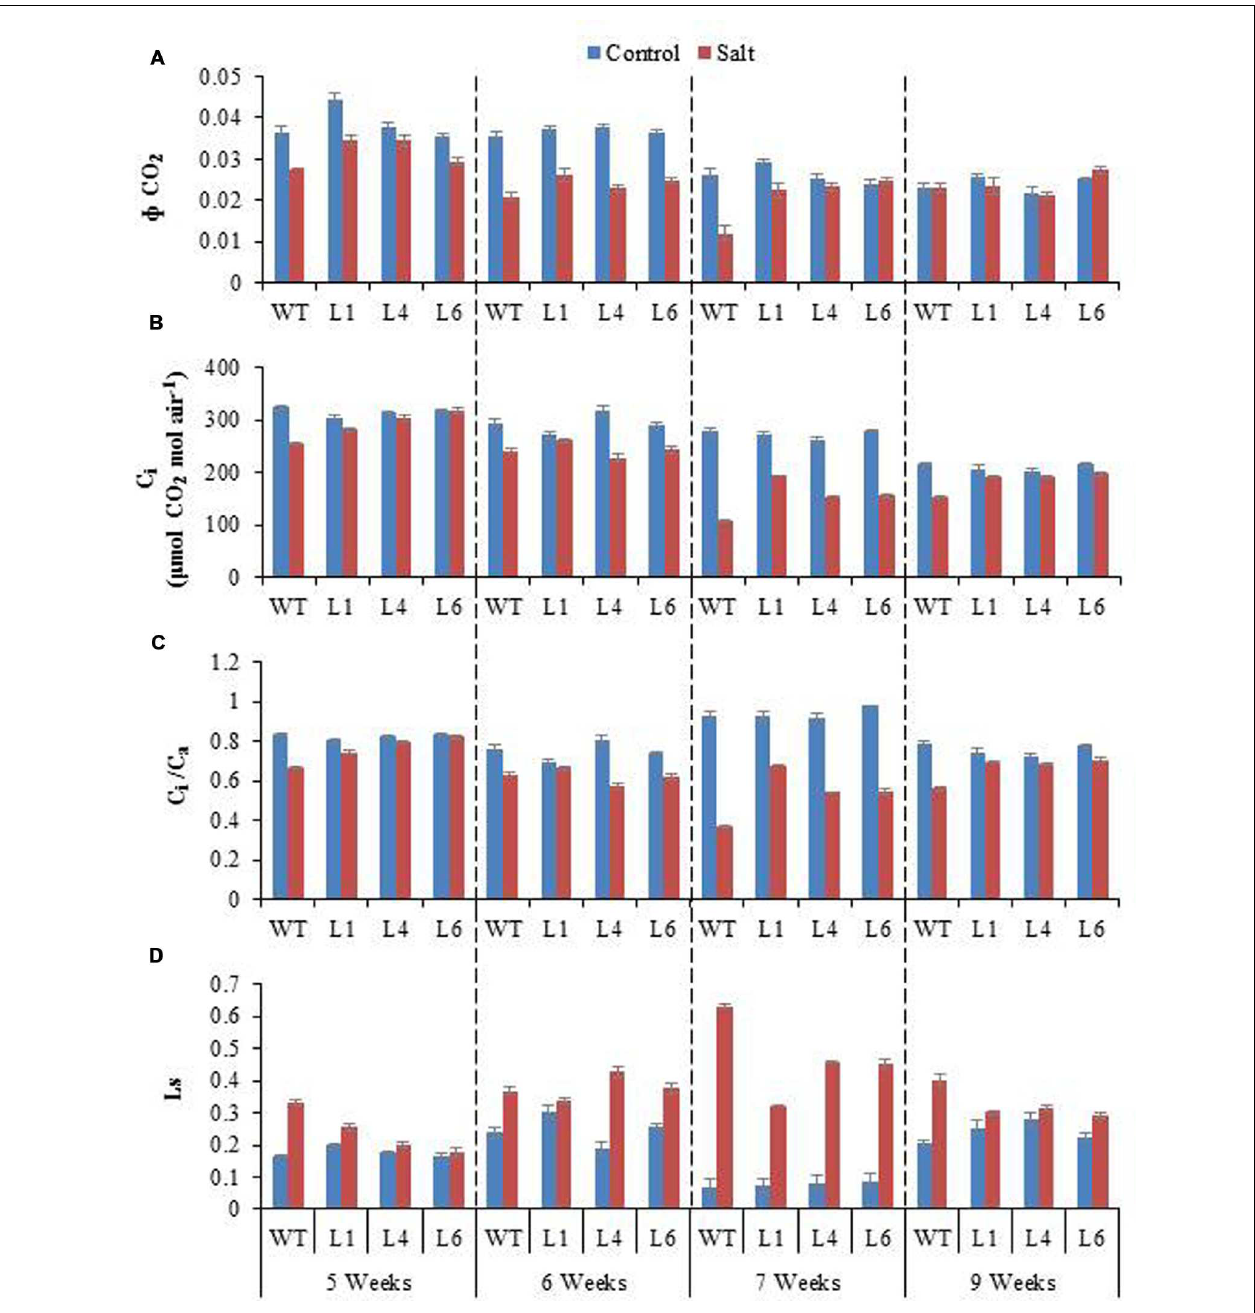
FIGURE 10 | (A) Comparison of maximum quantum yield of CO 2 assimilation ( (cid:56) CO 2 ), (B) Intercellular CO 2 concentration ( C i), (C) Ratio of intercellular to ambient CO 2 concentration ( C i /C a), and (D) Stomatal limitation value (Ls) of WT and transgenic lines (L1, L4, and L6) in response to the gradual exposure of stress from 5 to 7 weeks and after restoration (9